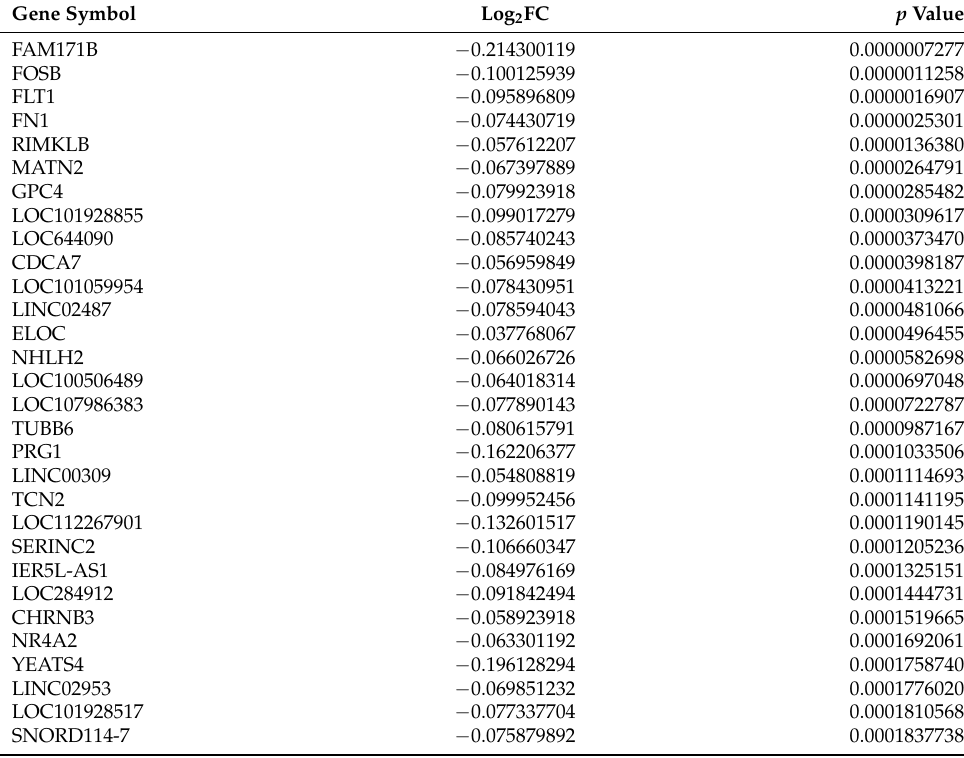
Table 3. Top 30 downregulated genes of the